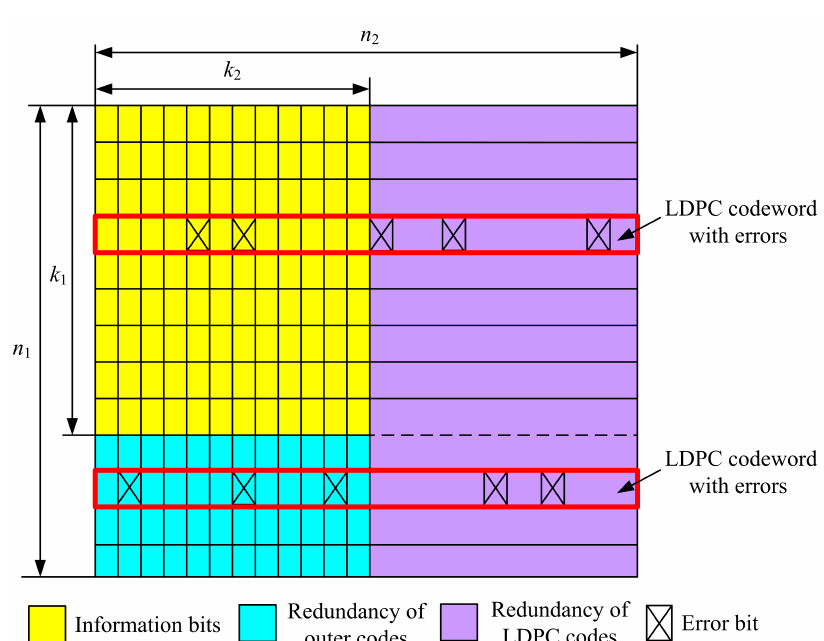
Figure 3. Errors in the LDPC codewords dispersed into multiple outer